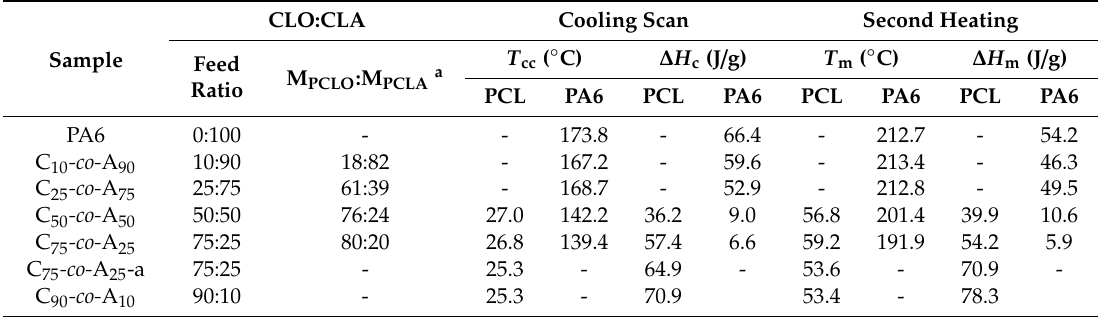
Table1. Themolarratioanddi ff erentialscanningcalorimetry(DSC)dataofP(CLA -co-